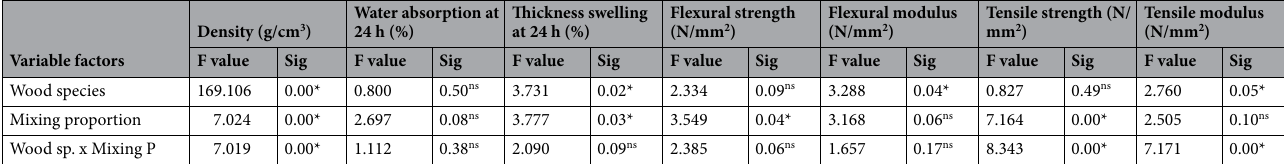
Table 2. Summary of statistical analysis of variance carried out on data obtained for physicomechanical properties. * represents significant, ns represents not significant at 5% level of probability, while sp represents species and P represents proportion.